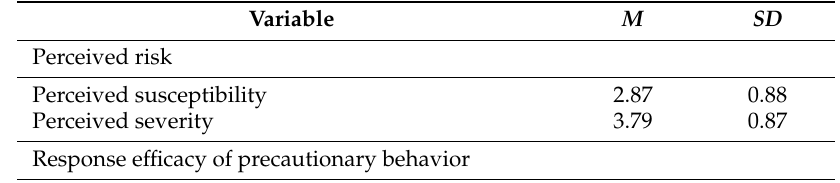
Table 2. Psychological and behavioral responses on